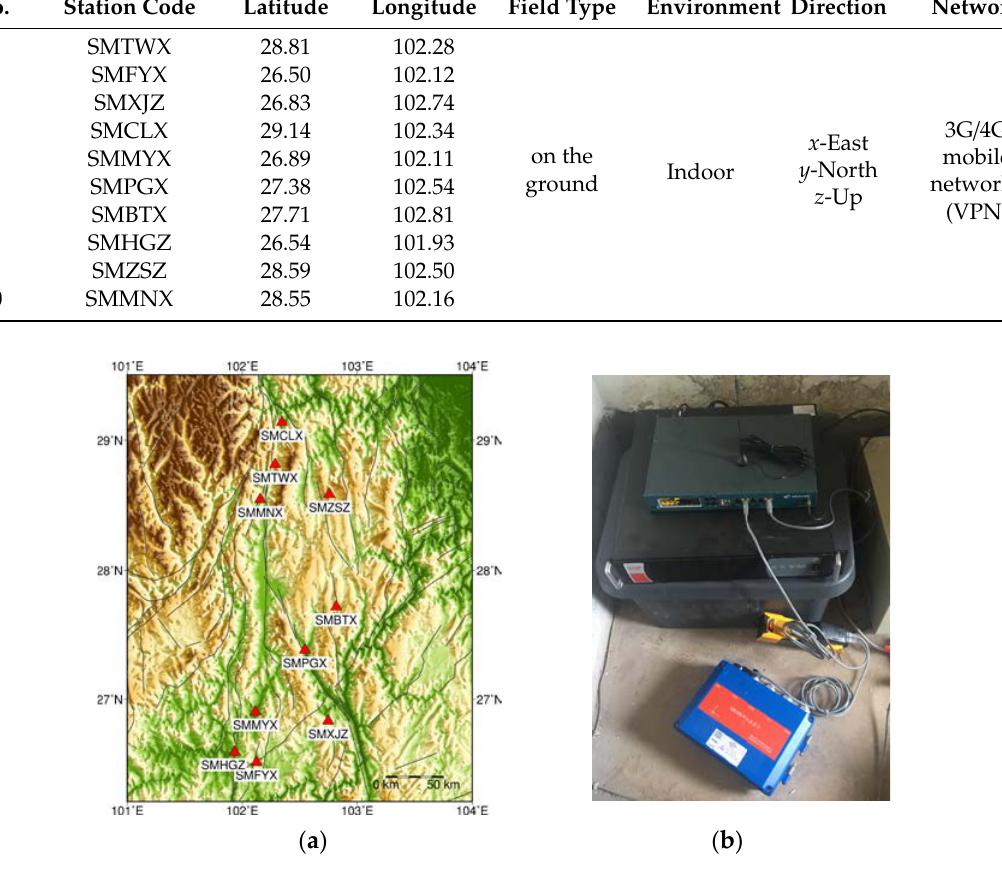
Figure 2. Locations and the station equipment of the tested MNSMSs: ( a ) Depiction of the MNSMSs’